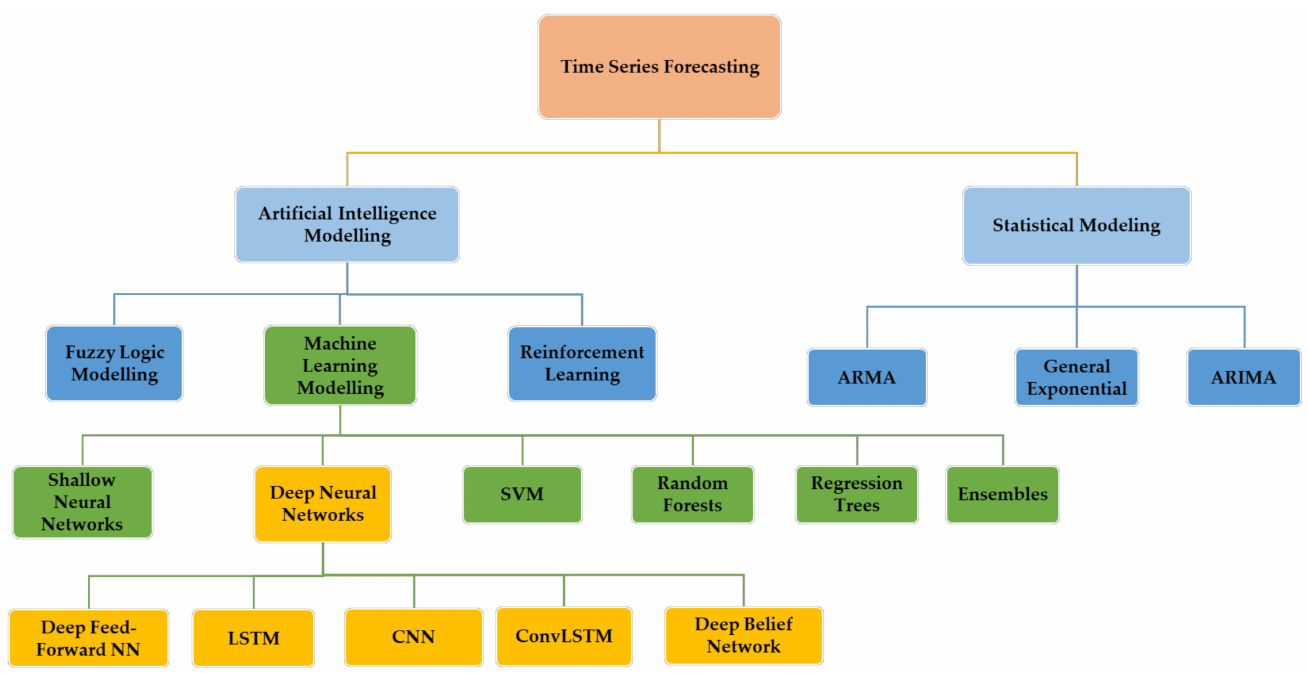
Figure 1. Illustration of time series forecasting